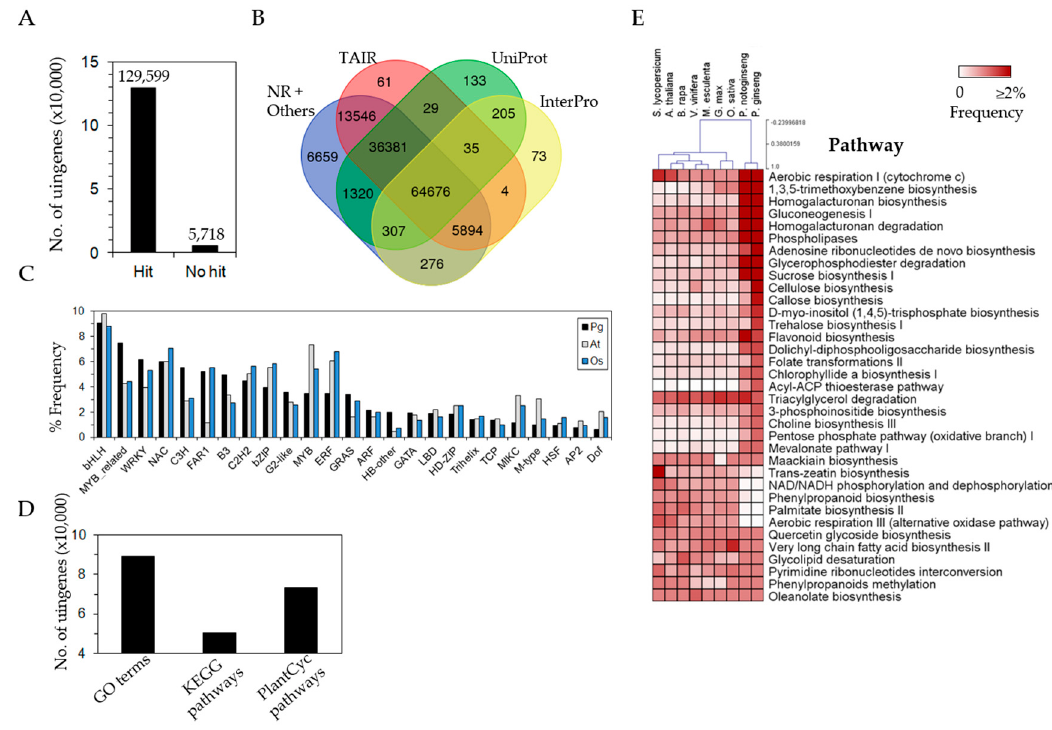
Figure 4. Functional annotation of unigenes. ( A ) The number of unigenes hits to known sequences. ( B ) Overlap of hits among known homologous genes searched against the different databases including UniProt, NR, TAIR, and InterPro. ( C ) The primary transcription factor (TF) families identified in unigenes. ( D ) The number of unigenes assigned to functional categories. ( E ) Abundance of unigenes assigned to the primary Plant Metabolic Pathways (PMN). Abundances of genes in Arabidopsis thaliana , Manihot esculenta , Brassica rapa , Vitis vinifera , Oryza sativa , Glycine max , Solanum lycopersicum , P. ginseng and P. notoginseng assigned to the PMN pathway were compared and represented in a heatmap. Pg: P. ginseng ; At: A. thaliana ; Os: Oryza sativa .